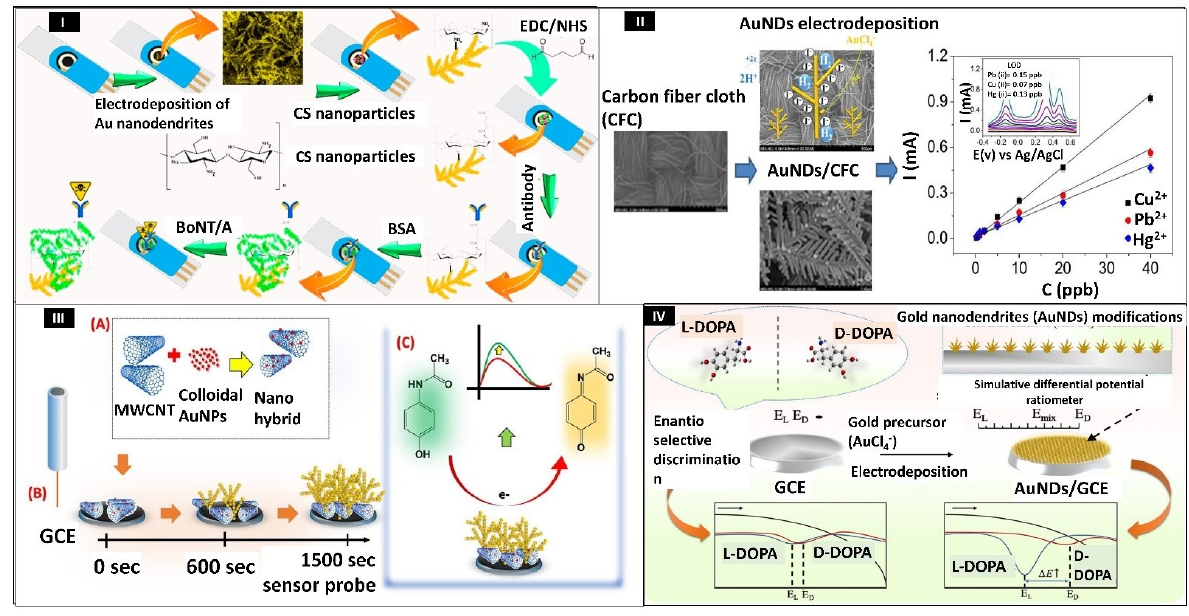
Figure 2. ( I ) Schematic illustration showing the immunosensing of botulinum neurotoxin type A. Reprinted with permission from [97]. Copyright 2017, Sorouri et al. ( II ) Illustration depicting carbon fiber cloth-based gold nanodendrites sensor for Pb (II), Hg (II), and Cu (II). Reprinted with permission from [98]. Copyright 2018, Dang et al. ( III ) Schematic representation of fabrication of sensor surface for detecting acetaminophen. ( A ) nanohybrid preparation, ( B ) dendrite deposition, and ( C ) illustrating the ratiometric sensing of DOPA by using gold nanodendrites. Reprinted with permission from [99]. Copyright 2020, Lian et